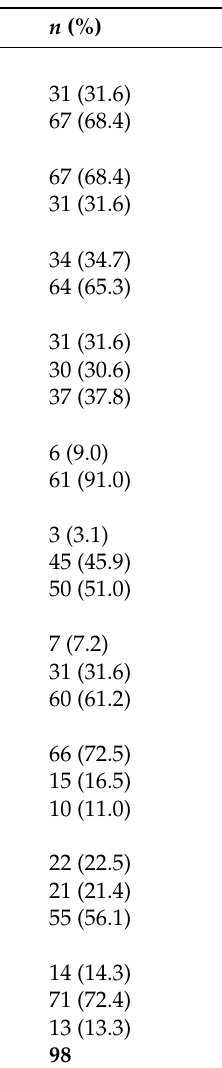
Table 1. Distribution according to selected variables of the 98 women enrolled into the DAMA25 study (The DAMA25 study, Florence, Italy, 2016–2017).